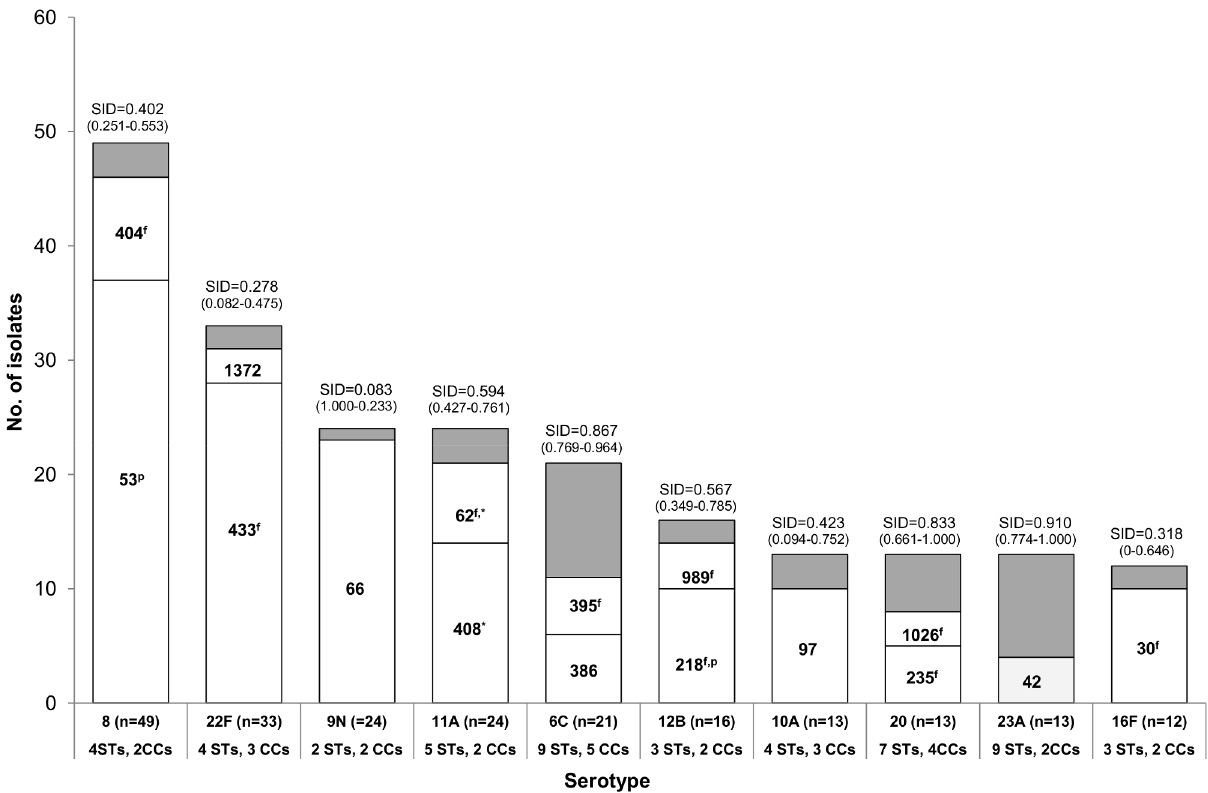
Fig 2. Distribution of STs according to serotype of the isolates causing adult IPD in 2008 – 2011 and expressing the 10 most frequent serotypes not included in any of the conjugate vaccines. The respective SID values are shown on top of the bars and in parenthesis are the respective confidence intervals. In grey are represented the isolates included in STs with < 3 isolates. These were: serotype 8 – ST1012 (n = 2) and ST 9969 (n = 1); serotype 22F – STs 10053 and 10220 (n = 1, each); serotype 9N – ST3982 (n = 1); serotype 11A – STs 9955, 9960 and 10052 (n = 1, each); serotype 6C – STs 1150, 1692 and 3396 (n = 2, each) and STs 1390, 1715, 2667 and 4310 (n = 1, each); serotype 12B – ST6180 (n = 2); serotype 10A – STs 156, 816 and 3135 (n = 1, each); serotype 20 – STs 1483, 1871, 7221, 9958 and 10047 (n = 1, each); serotype 23A – ST338 (n = 2) and STs 190, 311, 438, 6177, 7960, 8866 and 10048 (n = 1, each); serotype 16F – STs 570 and 5902 (n = 1,